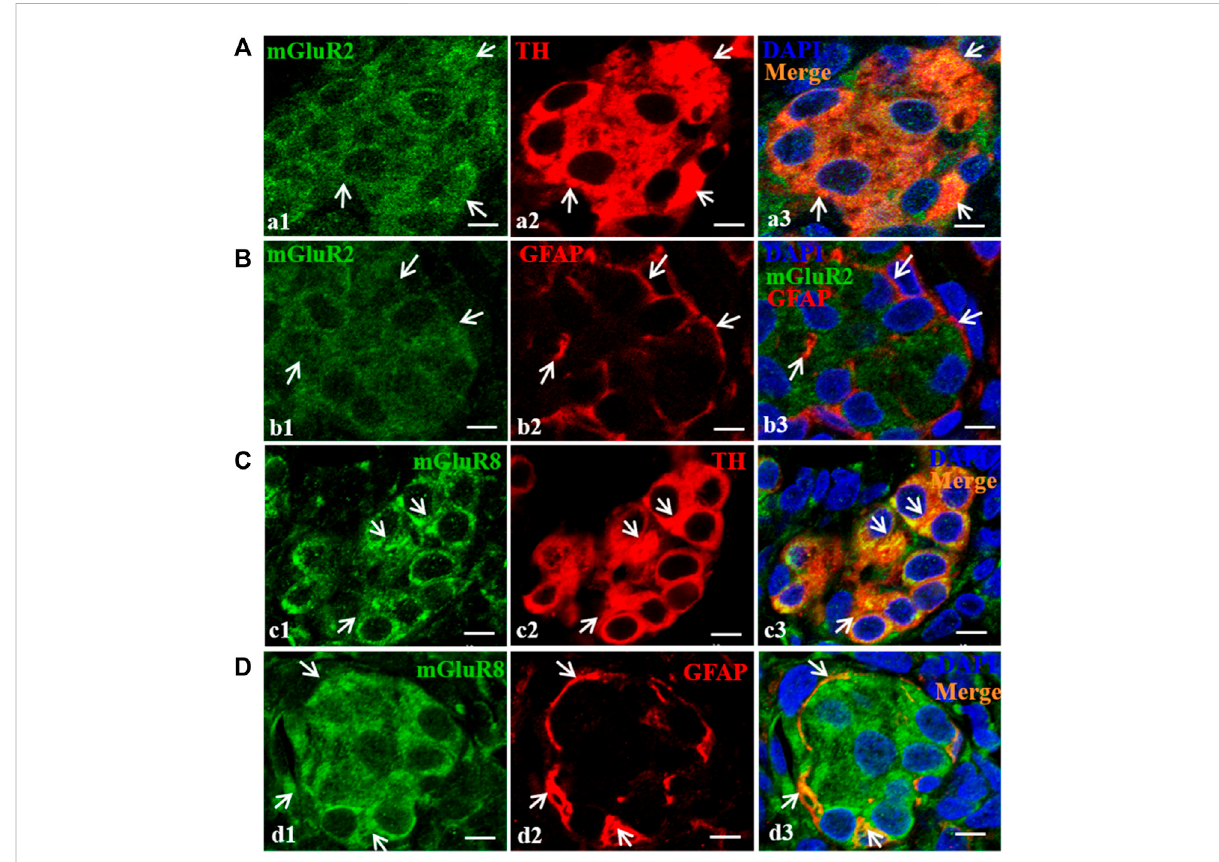
FIGURE 3 Distribution of mGluR2 and mGluR8 in rat CB. Figure (A) and (C) are double immuno fl uorescence staining of mGluR2 (Figure a1) or mGluR8 (Figurec1,green)withTH(Figurea2orc2,red)inratCB.Figure (B) and (D) aredoubleimmuno fl uorescencestainingofmGluR2(Figureb1)ormGluR8 (Figure d1, green) and GFAP (Figure b2 or d2, red) in rat CB. Some TH-immunoreactive type I cells are immunoreactive for mGluR2 (Figure a3, arrowheads), whereas the GFAP-immunoreactive type II cell are not immunoreactive for mGluR2 (Figure b3). Some TH-immunoreactive type I cells and the GFAP-immunoreactive type II cells were immunoreactive for mGluR8 (Figure c3 and d3, arrowheads). TH, tyrosine hydroxylase, the CB type I cell marker; GFAP, glial fi brillary acidic protein, the CB type II cell marker; mGluR, glutamate metabotropic receptor. Scale bar = 5 μ m for all